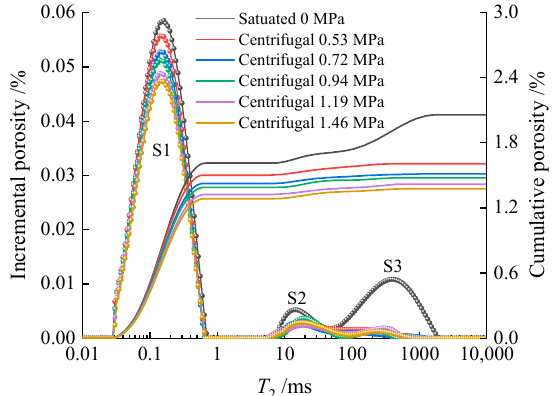
Figure 5. NMR T 2 spectra of sample F after centrifugation with different centrifugal forces.